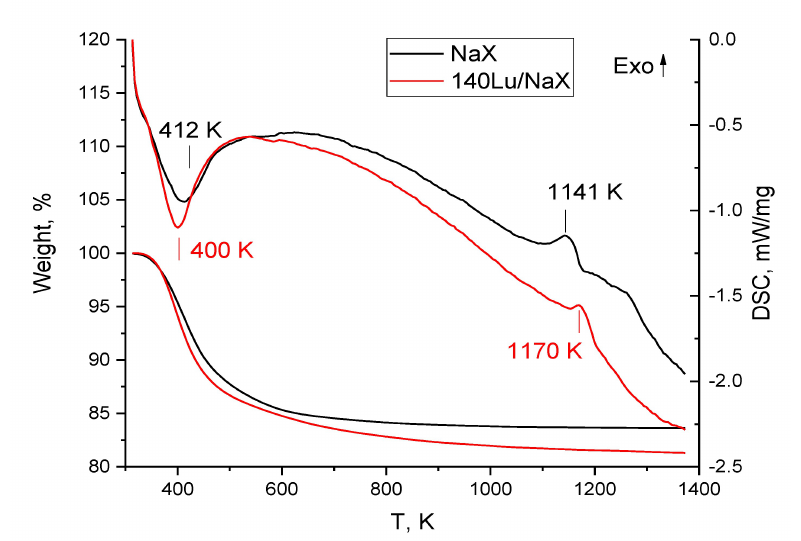
Figure 6. TG-DSC curves for the NaX microspheres without Lu 3+ (NaX) and loaded with Lu 3+ (140 Lu/NaX).